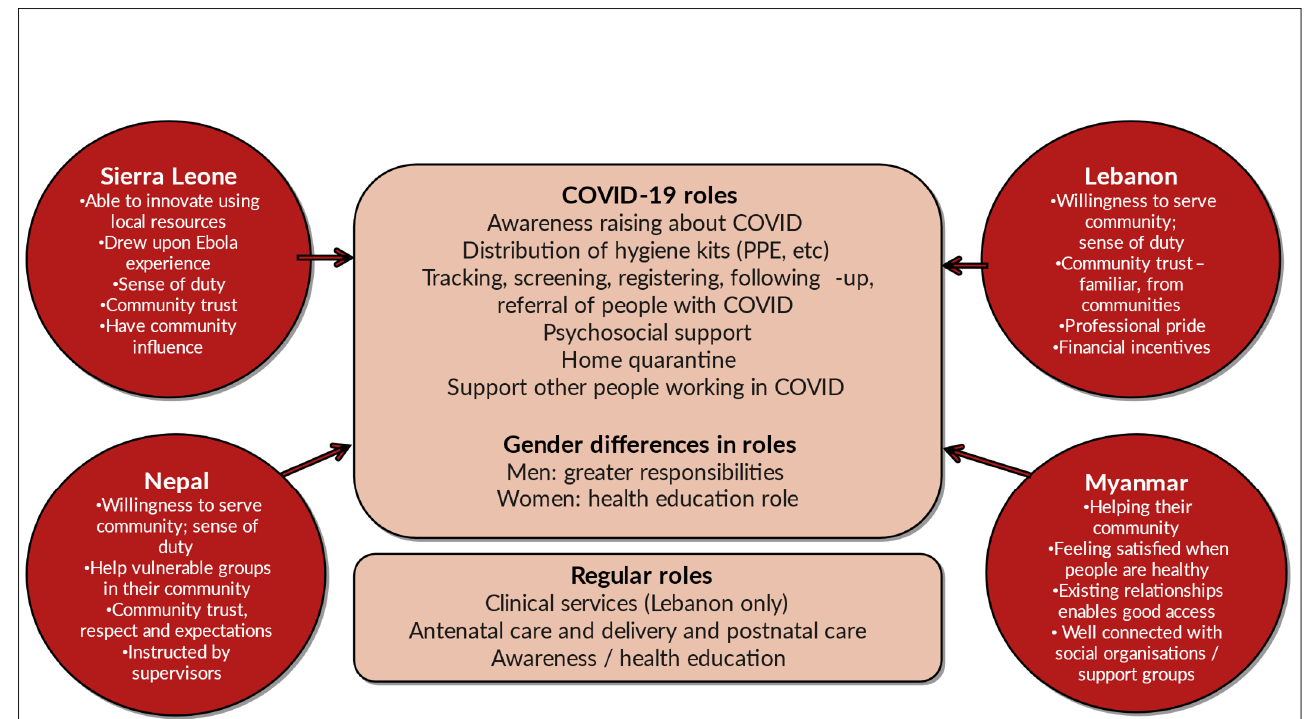
Figure 2. Adapting roles and responsibilities of CTC providers during COVID-19 . Workload and